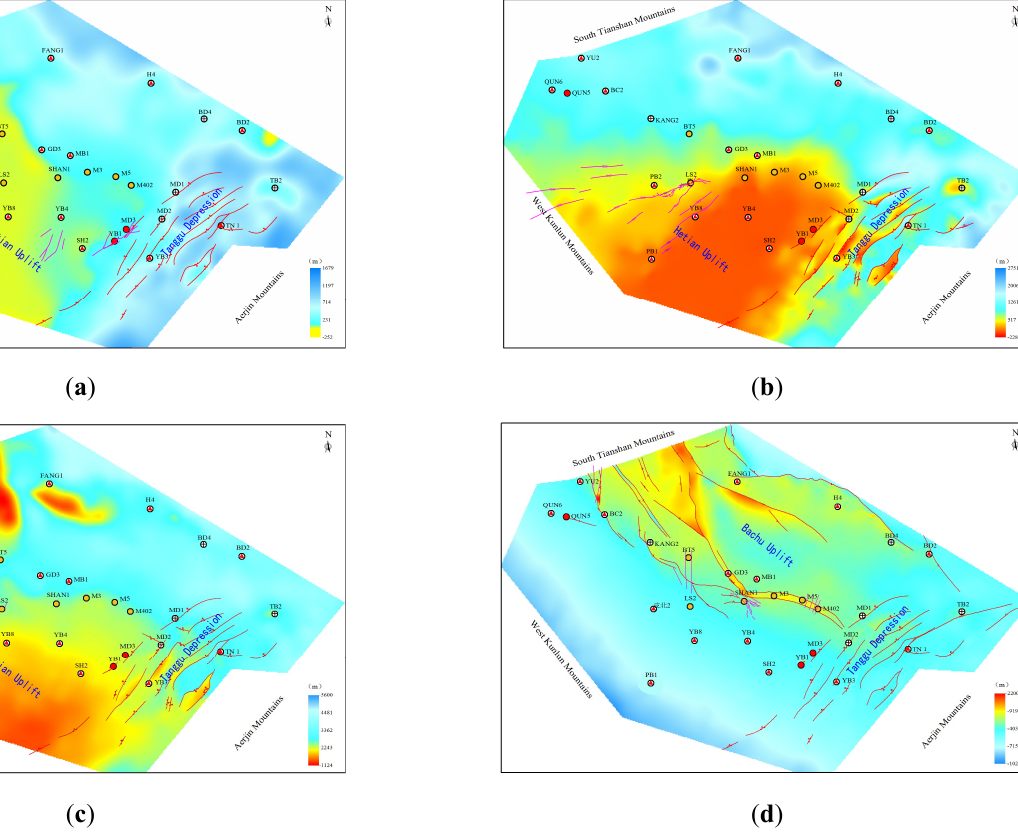
Figure 7. Structure of Ordovician top and strike-slip fault in different periods, Bachu-Maigaiti area. ( a ) Paleotectonic map of top surface of Ordovician–late Caledonian. ( b ) Paleotectonic map of top surface of Ordovician–early Hercynian. ( c ) Paleotectonic map of top surface of Ordovician–late Hercynian. ( d ) Tectonic map of top surface of Ordovician–present day.